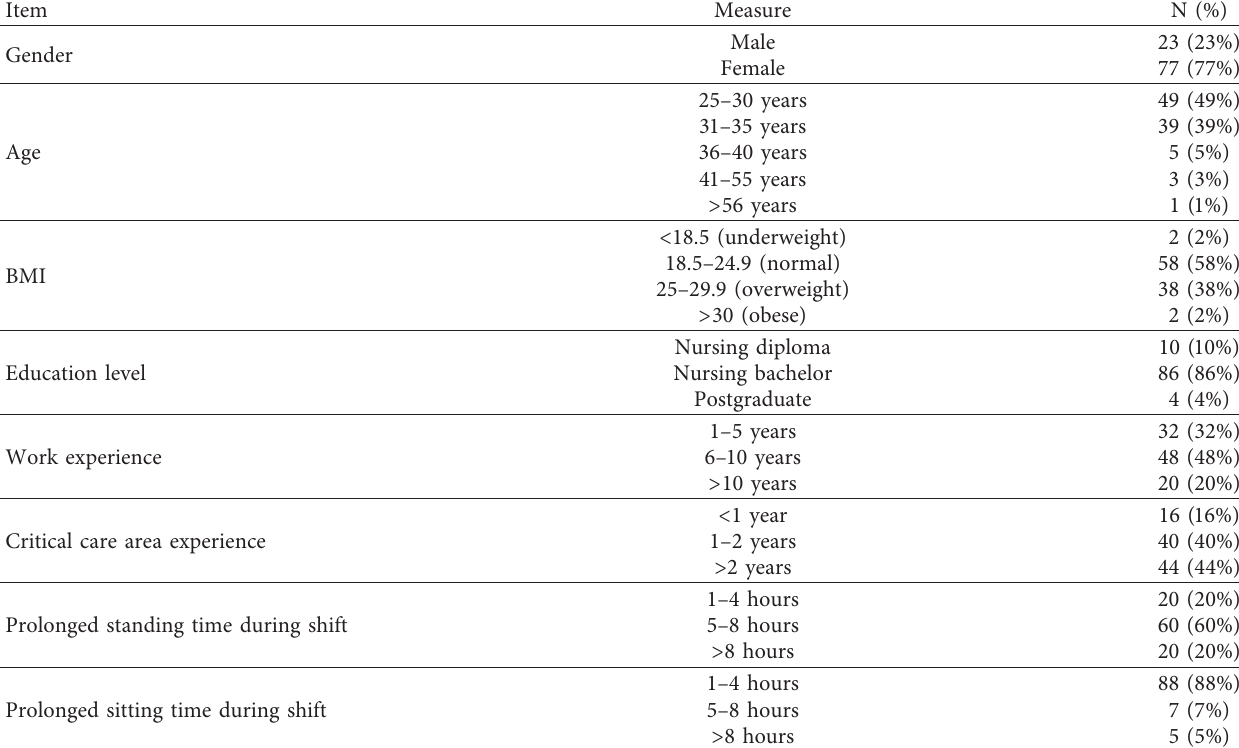
Table 1: Demographic profile of the